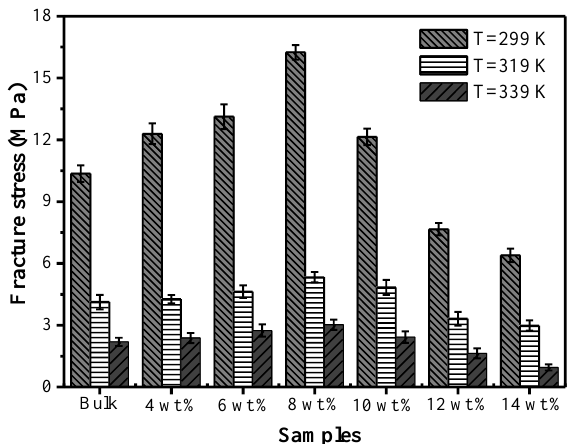
Figure 9. The effects of different chopped carbon fiber contents on fracture stress at three test temperatures of 299 K, 319 K and 339 K.